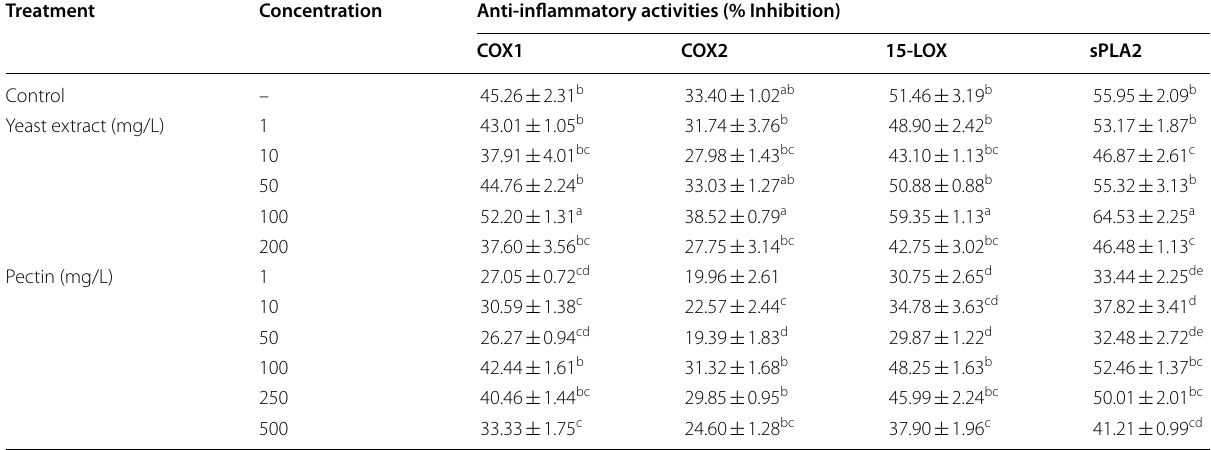
Values represent means standard errors from triplicates; different letters indicate significant differences at p < ±